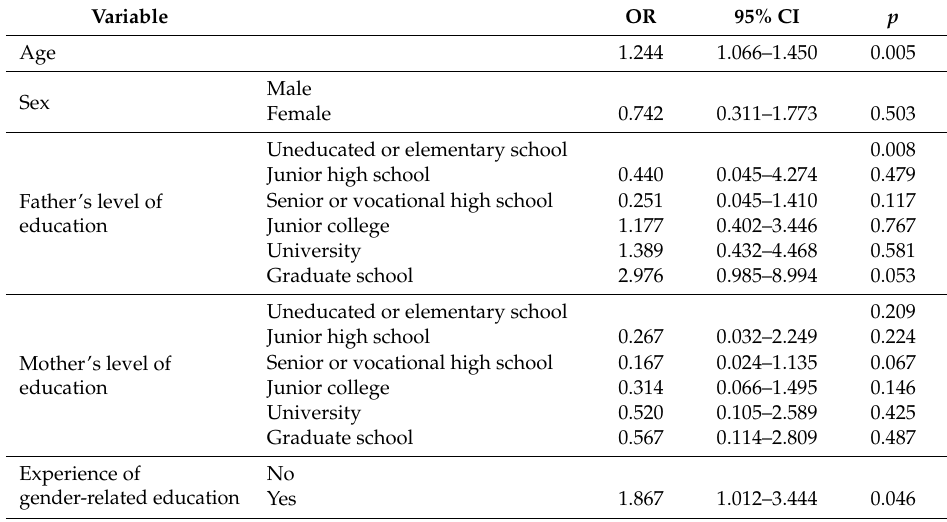
Table 4. Logistic regression analysis of the relevant factors a ff ecting participants’ sexual harassment experience ( n =